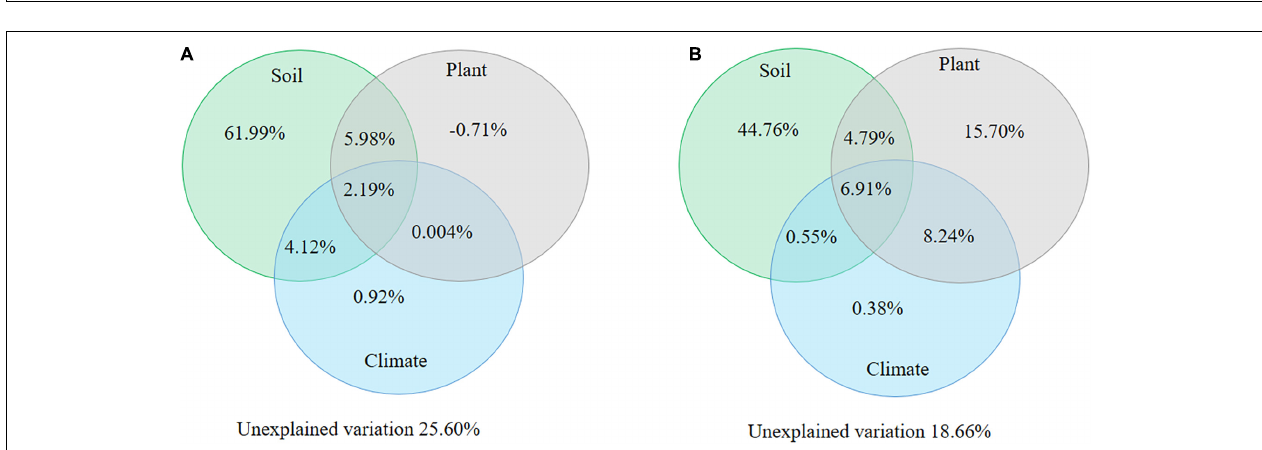
FIGURE 6 | The relationships among nitrogen: phosphorus (N:P) ratio in foliage (A) , stem (B) , root (C) , and soil N:P ratio. Yellow circles indicate desert shrublands, while green circles indicate alpine shrublands.